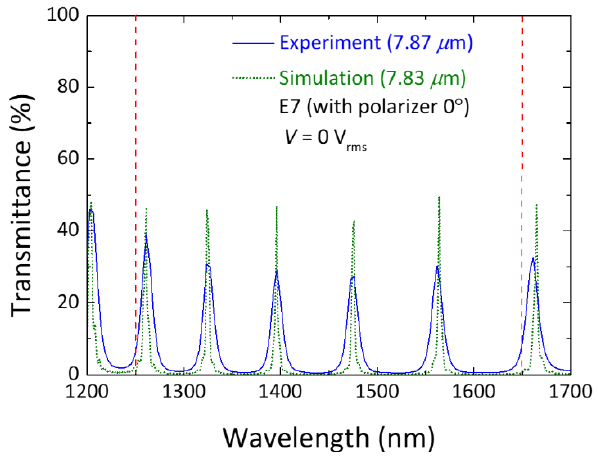
Figure 6. Experimental (blue solid curve) and simulated (green dotted line) polarized transmission spectra of the PC/LC microcavity with a large cell gap determined by 8 μm spacers at zero voltage. The spectral peaks specify the wavelengths of e -mode signals of successive orders of interference.